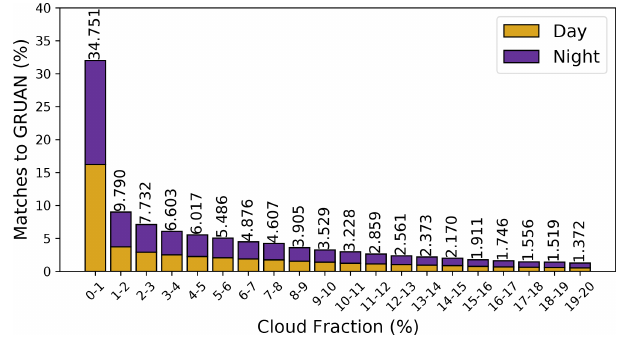
Figure B1. Like Fig. 9, stacked histogram of IMS collocations to GRUAN sites split into 1% cloud cover intervals between 0%– 10%. Again, results are separated into day and night cases with the total number of matches shown at the top of each